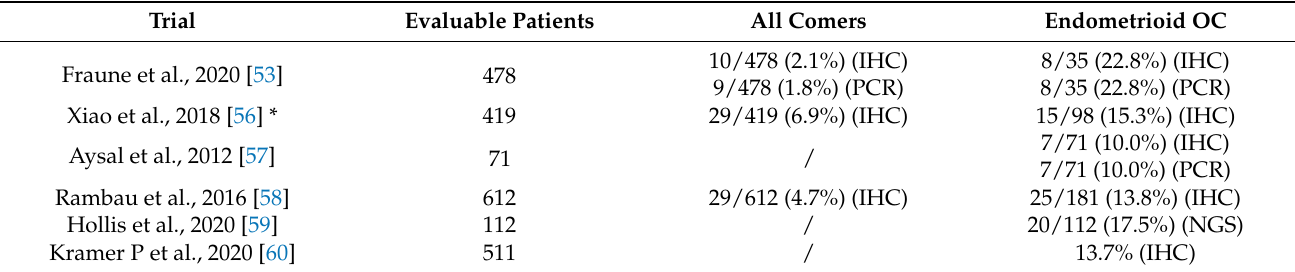
Table 4. Main references concerning dMMR/MSI status in ovarian